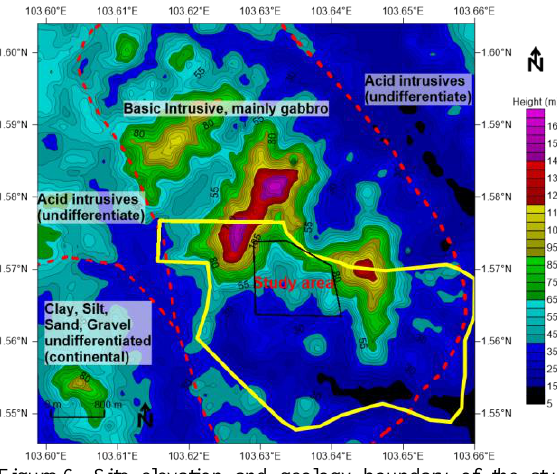
Figure 6 Site elevation and geology boundary of the study